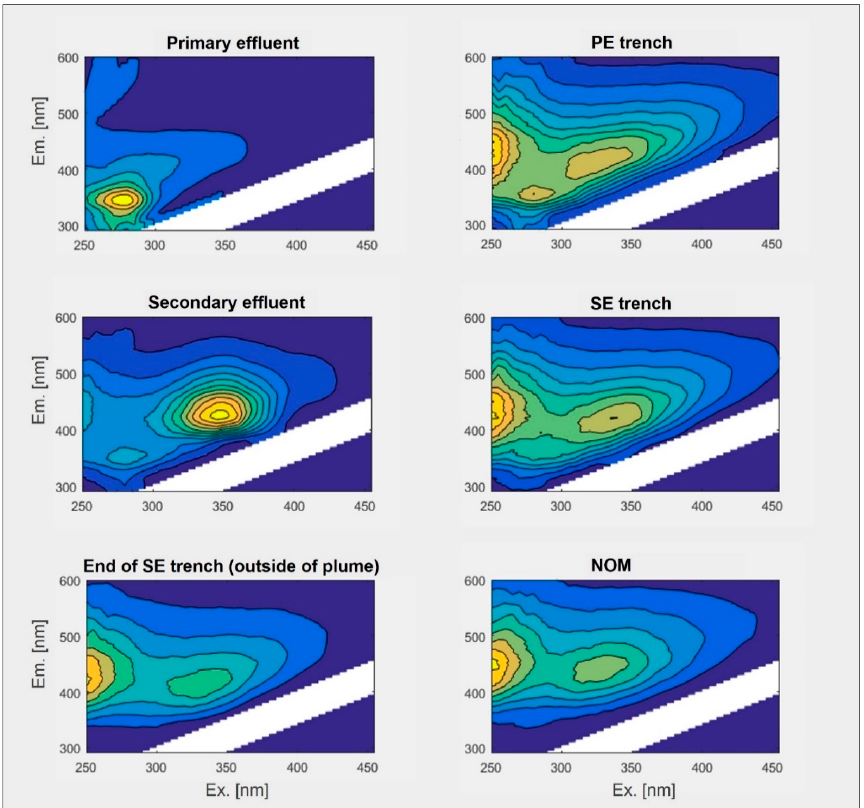
Figure 3. EEMs for primary, secondary effluent, trench samples and Suwannee river NOM. The selected examples are from Site 2 in March 2017. The “PE trench” sample was collected from 10 m, the “SE trench” sample from 1 m and the “End of SE trench” control sample from 17.5 m along the trench.